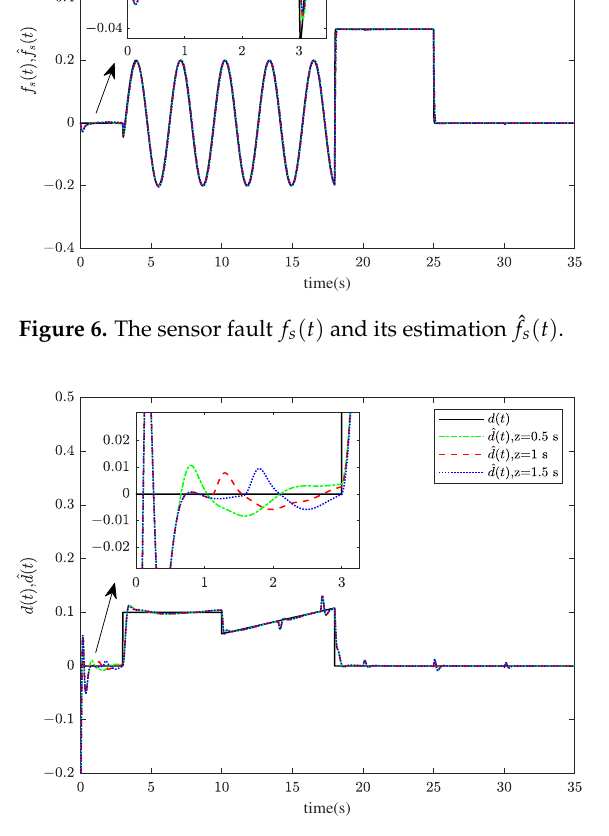
Figure 7. The unknown input disturbance d ( t ) and its estimation ˆ d ( t ) .